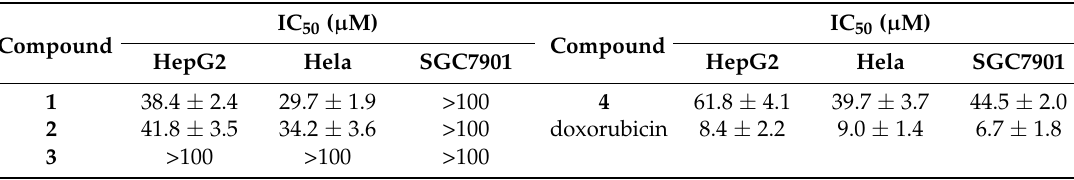
Table 4. Cytotoxicity of compounds 1 – 4